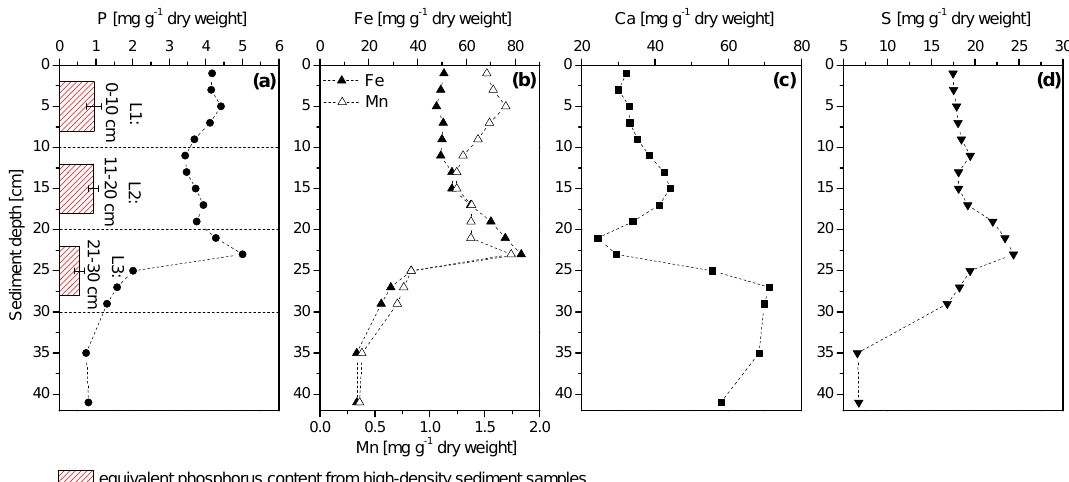
Figure 6. Sediment stratigraphic chart of (a) phosphorus (P), (b) iron (Fe) and manganese (Mn), (c) calcium (Ca) and (d) sulfur (S) of Lake Groß-Glienicke from May 2013. Bar charts in graph (a) represent the equivalent P content analysed in the high-density samples from depth layers L1, L2 and L3. Error bars denote ± SD, n =